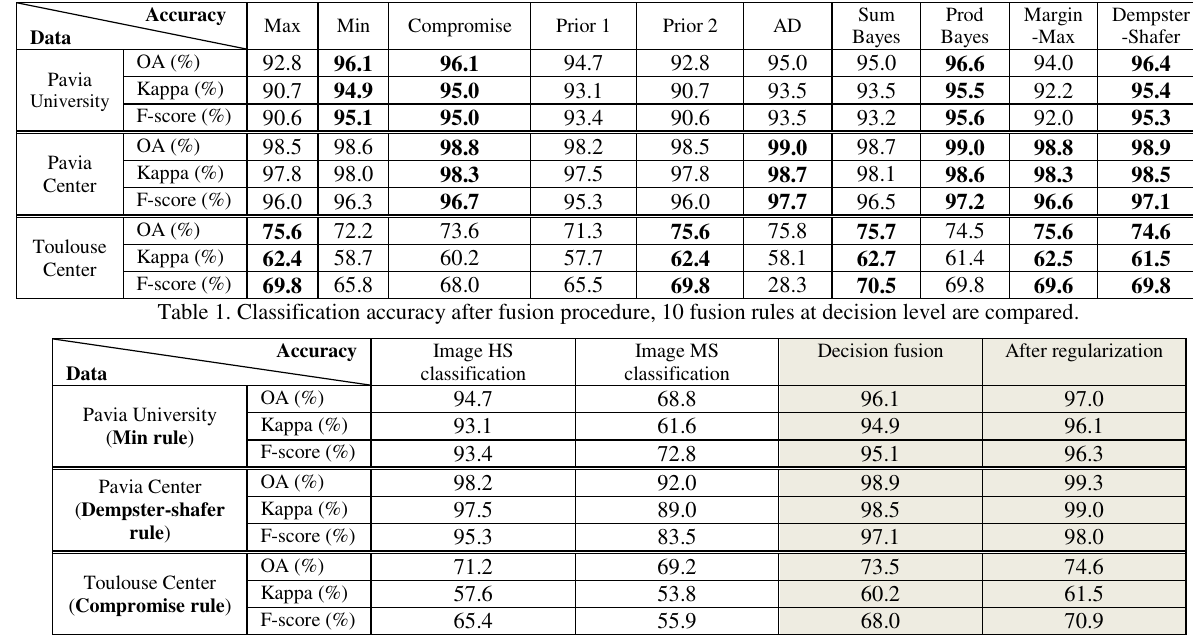
Table 1. Classification accuracy after fusion procedure, 10 fusion rules at decision level are compared.